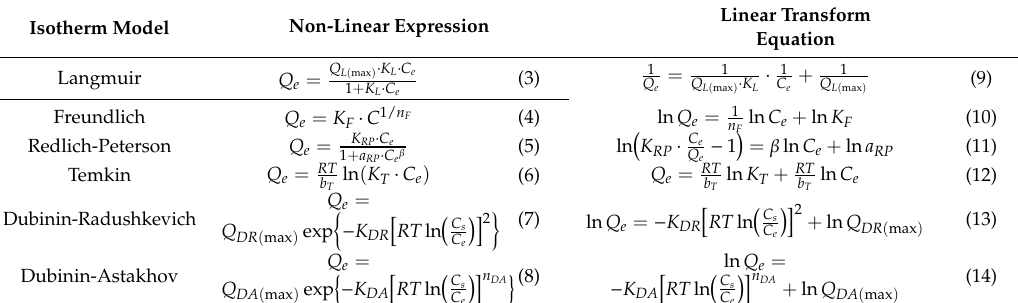
Table 1. Nonlinear and linear representation of adsorption